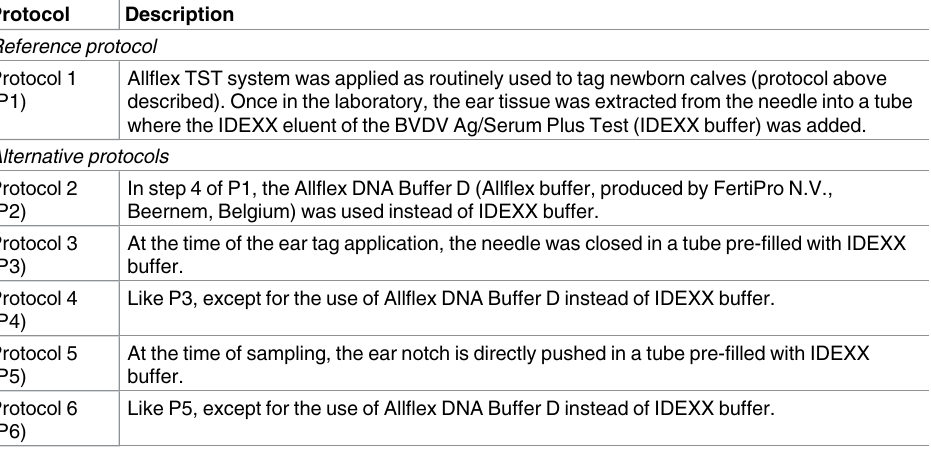
Table 1. Description of the protocols used in the